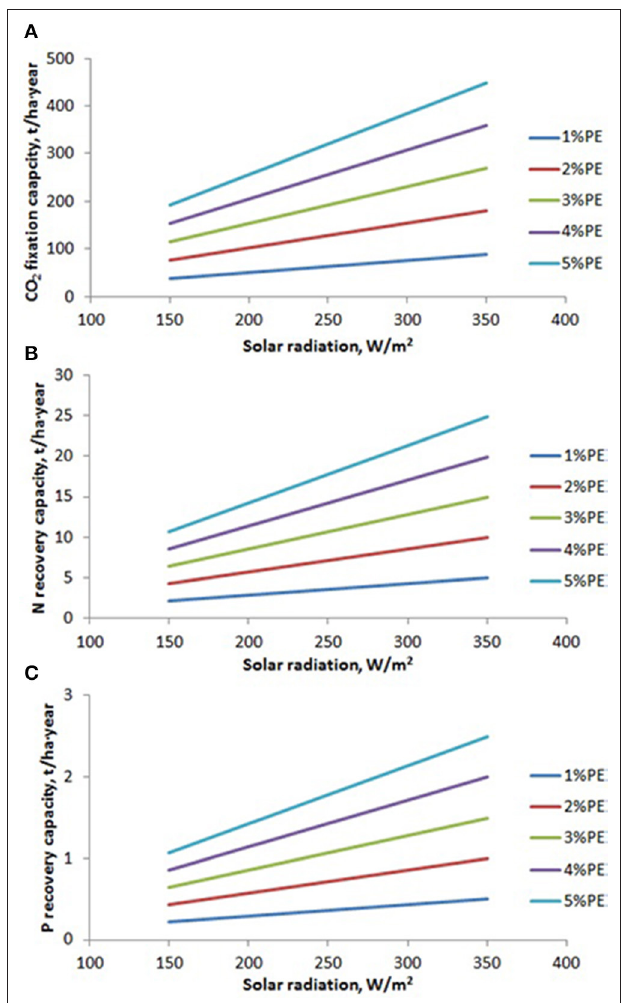
FIGURE 2 | Variation of CO 2 , N, and P recovery capacity as a function of solar radiation availability and photosynthetic efficiency achieved in the production system. (A) CO 2 fixation capacity, (B) N recovery capacity, (C) P recovery